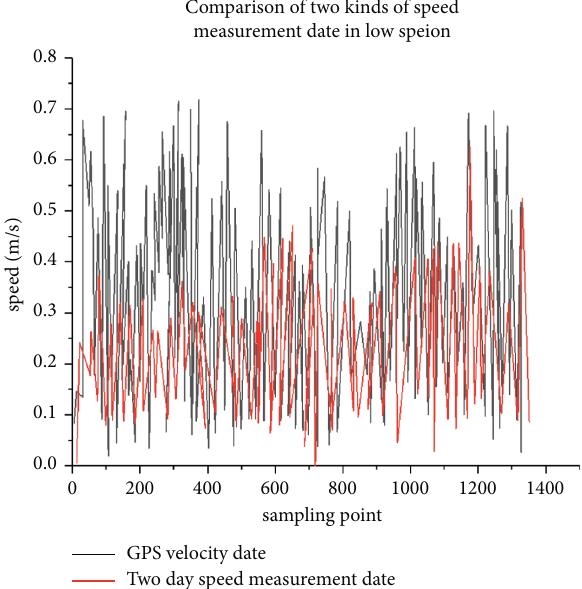
Figure 3: Comparison of two kinds of velocity measurement data in low speed and open environment.